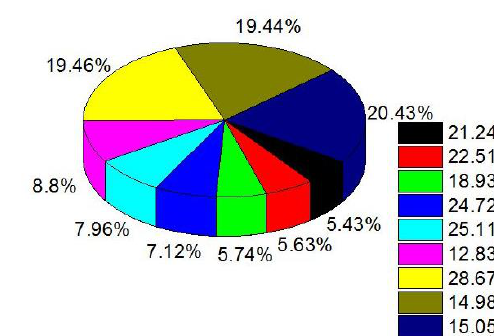
Figure 6: MRR and Energy Consumed analysis during